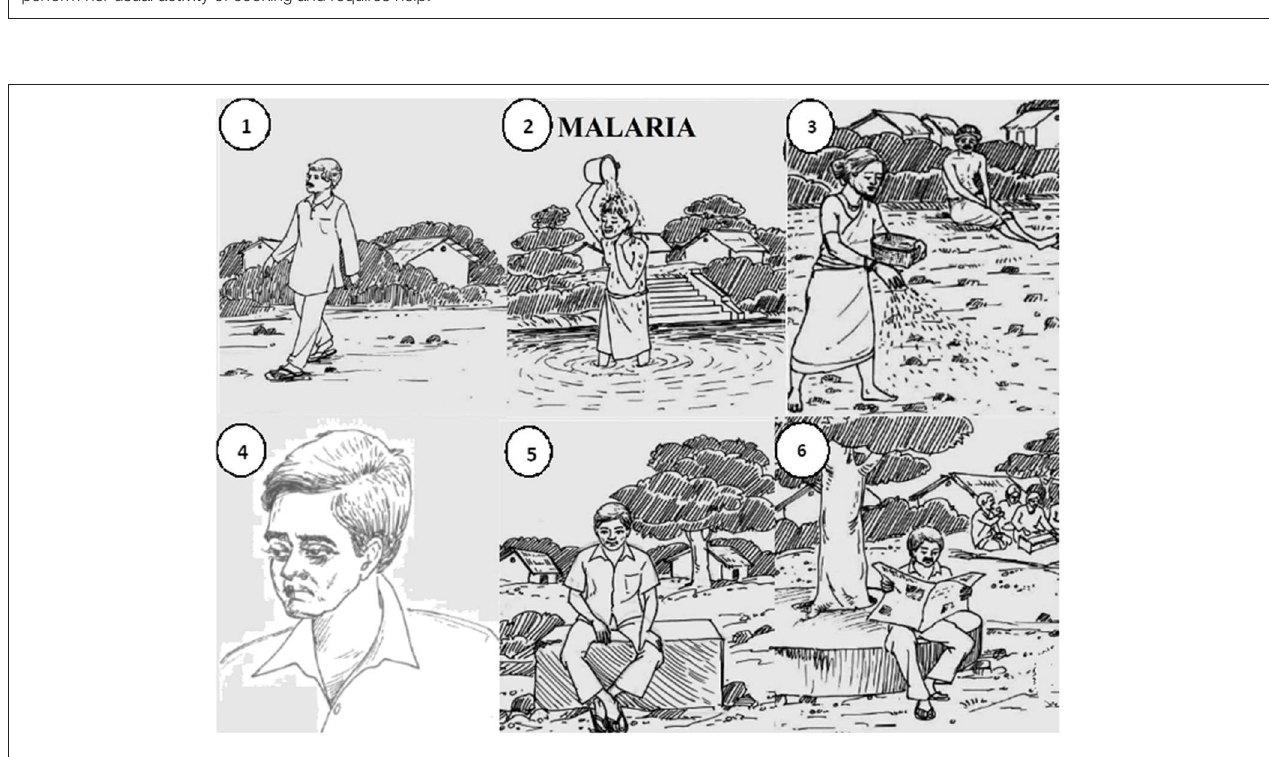
FIGURE 2 | 6D3L pictorial narration of Malaria with: (1) no problem in mobility, (2) no problem in self-care, (3) severe problem in usual activity, (4) mild/moderate pain/discomfort, (5) no anxiety/depression, and (6) no problem in cognition. The figure depicts the pictorial narration of Malaria as developed by expert panel and study team members, where the severity level of each dimension has been appropriately defined.